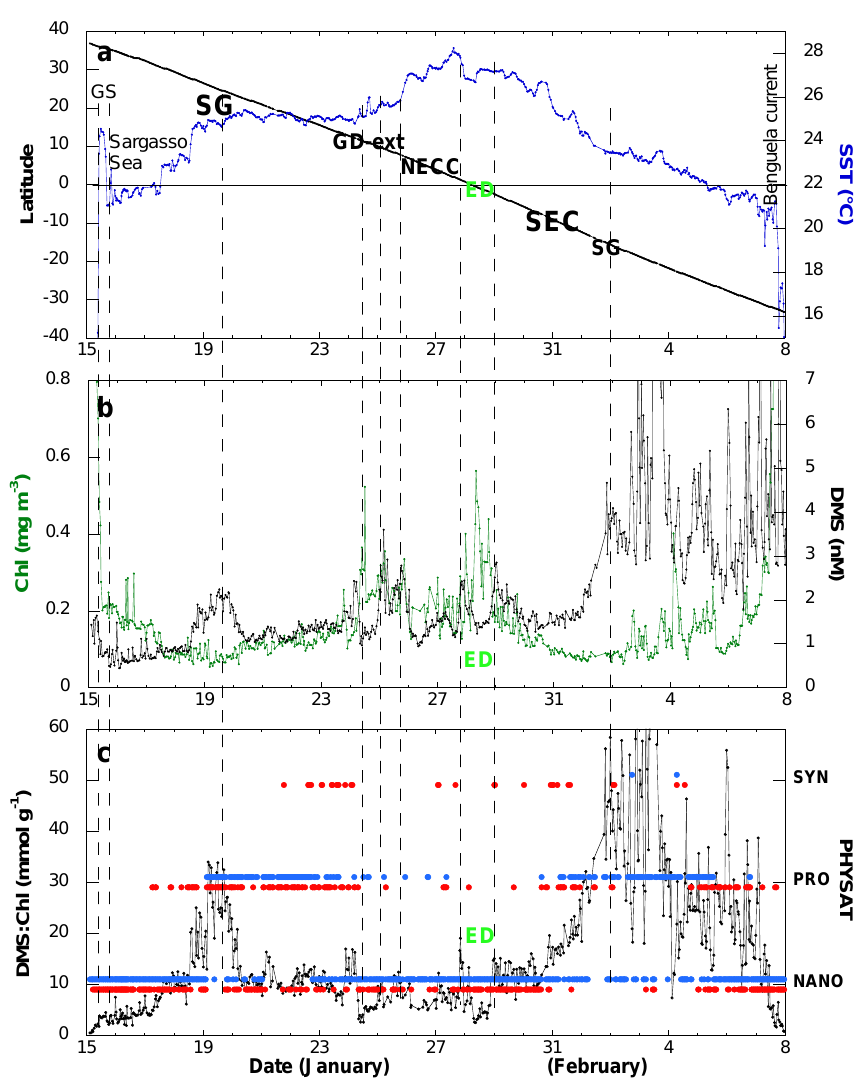
Fig. 9. Temporal variations of the following parameters in the north and south Atlantic Ocean (cruise CN-139): (a) sea surface temperature (SST: ◦ C, in blue) and latitude (in black), (b) ocean color (Chl: mgm − 3 , in green) and sea surface dimethylsulfide concentration (DMS: nM, in black), (c) DMS-to-Chl ratio (DMS:Chl, mmolg − 1 , in black) and monthly (red dots) and monthly climatological (blue dots) composites of phytoplankton group dominance. Chl levels over 0.8mgm − 3 were up to 2.7mgm − 3 and 9.1mgm − 3 off the North American and South African coasts, respectively. DMS levels over 7nM were up to 10.1nM and 11nM on 3 and 7 February, respectively. GS: Gulf stream, SG: subtropical gyre, GD-ext: Guinea dome extension, NECC: north equatorial counter current, ED: equatorial divergence, SEC: south equatorial